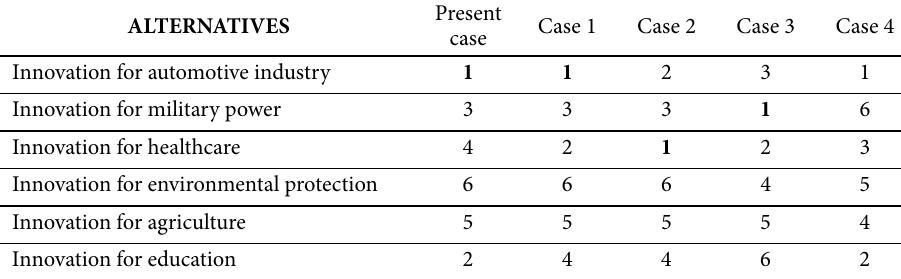
Table 10. Ranks of alternatives with respect to the